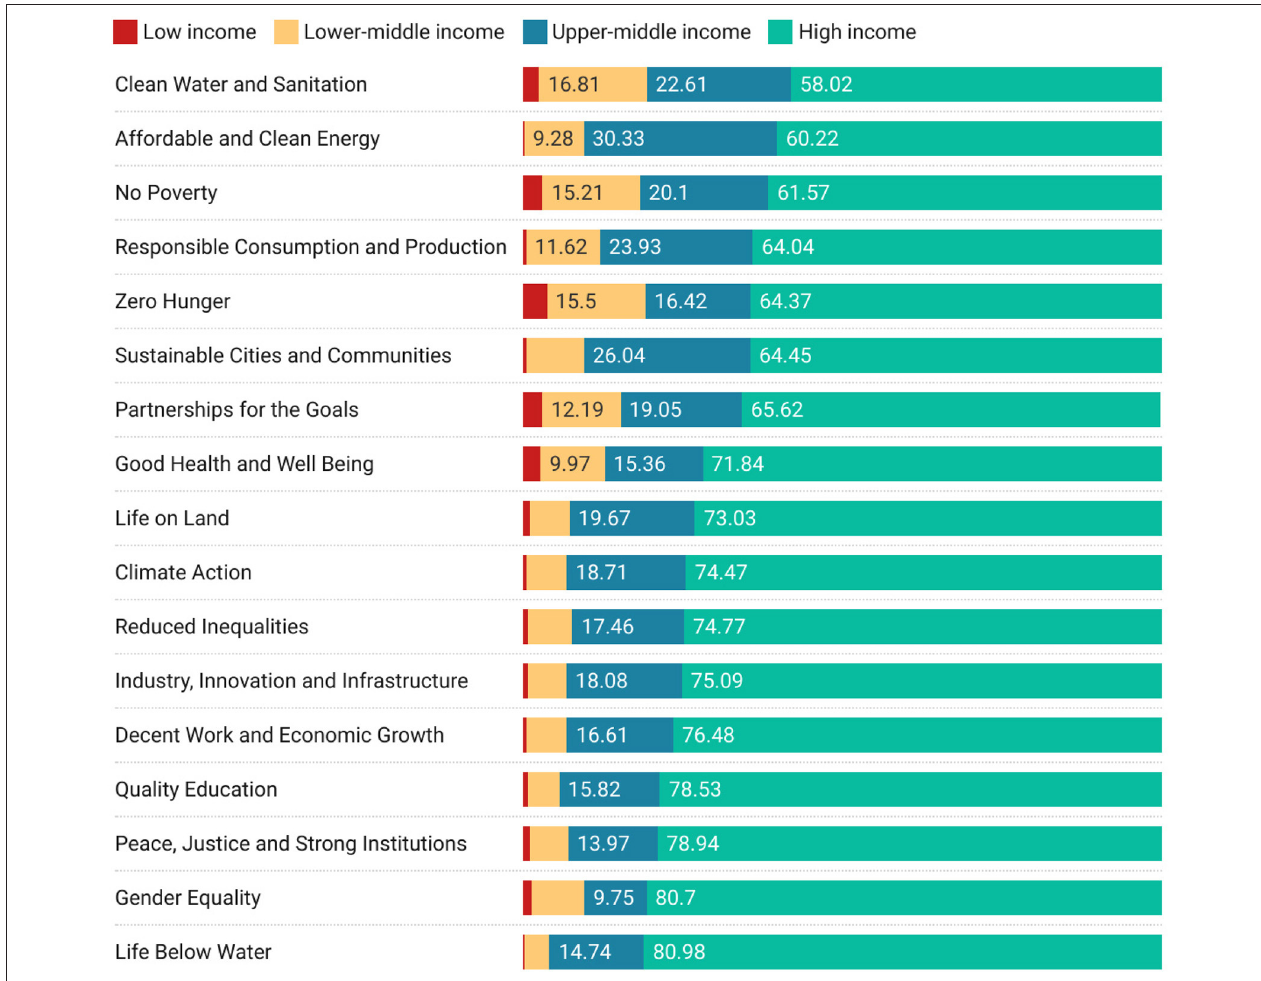
FIGURE 7 | Sustainable development goal collaborations from the perspective of low-income countries, ordered by cumulative non-high-income proportion of